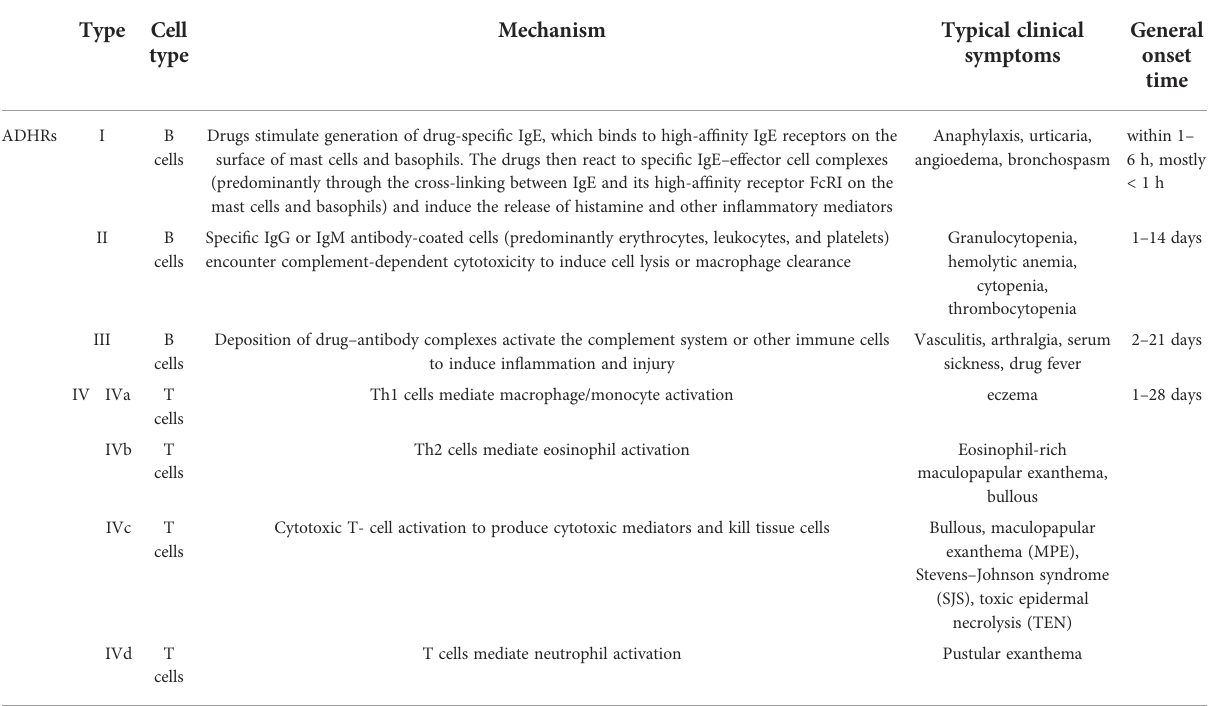
TABLE 1 Classi fi cation of ADHRs (3, 6, 14, 16 – 18).